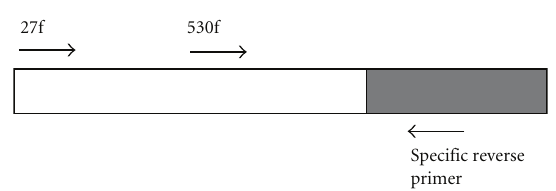
Figure 1: A diagram showing the position and the approach used to obtain full-length rrs gene. The shaded box represents the down- stream partial sequence determined in a previous study [13], while the open box represents the upstream partial sequence determined in this study. Each sequence-specific reverse primer was used to retrieve the upstream partial sequence and to quantify the abundance of each of the uncultured bacteria when paired with bacterial primers 27f and 5330f,